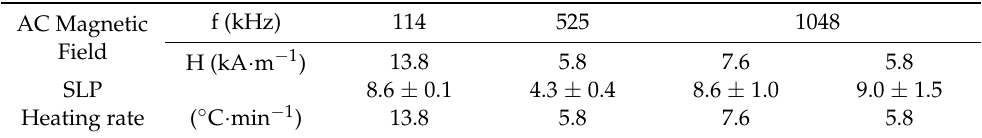
Figure 18. Inductive heating of composites with 7 wt.% of NPs at different alternating magnetic field parameters. Reprinted with permission [68]. Copyright 2021, Elsevier. Table 4. SLP values (W·g Fe–1 ) and heating rates (°C/min) of Nanoembosil ® in AMF of various frequencies and amplitudes.